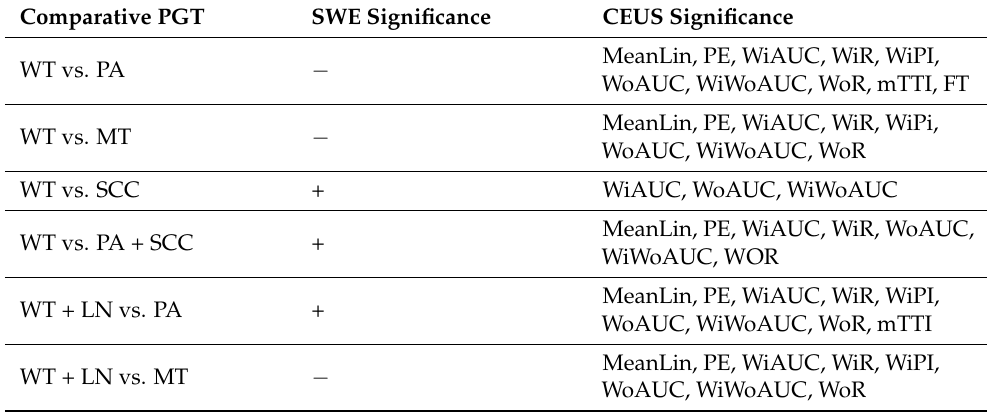
Table 2. Main results: overview of significant SWE and CEUS results, “ − “ denotes no signfi- cant and “+” denotes significant SWE-results. Abbreviations: SWE denotes shear wave